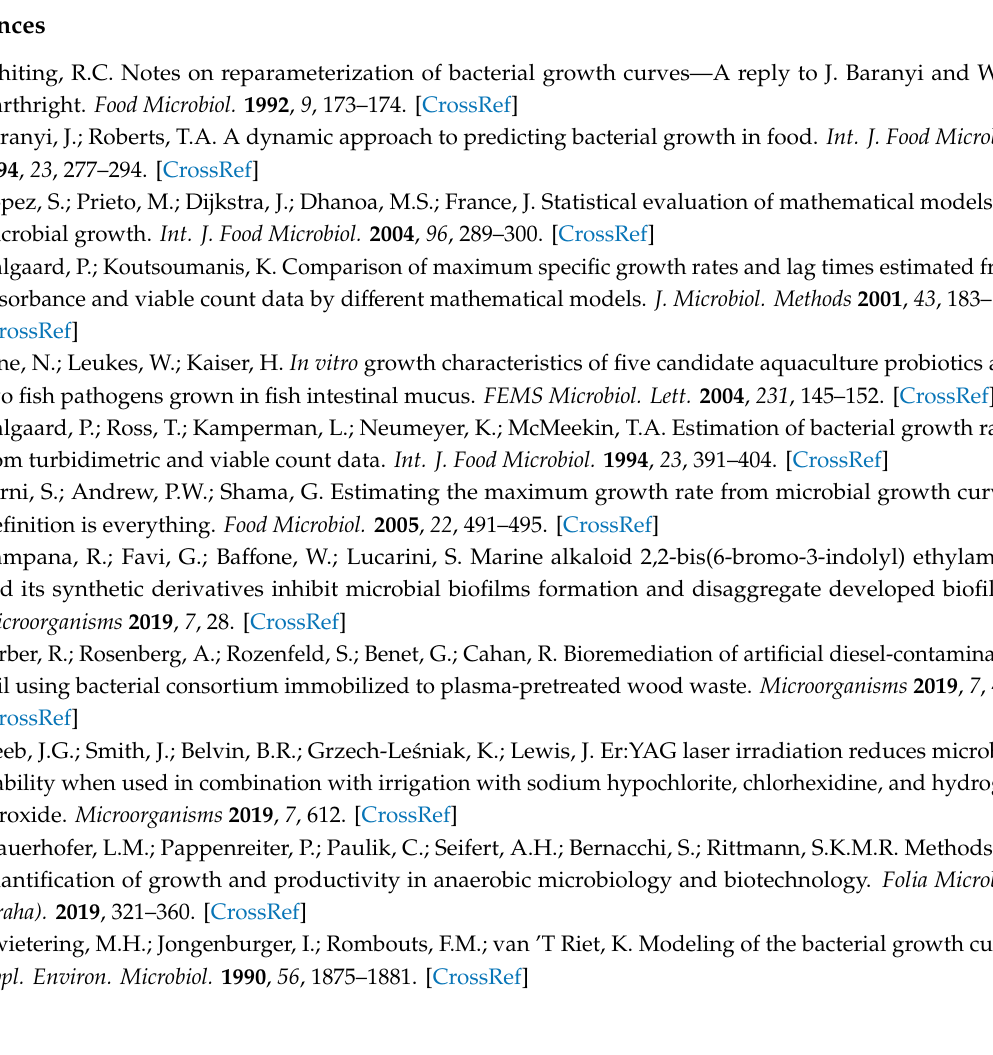
modified Cytophaga, (4) Cy7, (5) FLPB, (6) TYESB, (7) CBCM and (8) MAOB; Figure S1 : Optical density growth data and model predictions for Flavobacterium psychrophilum . Growth predictions using (a) LOG, log × hyp, log × exp (b) MLOG and BAR grown on a Sheih liquid medium; Figure S2: Optical density growth data and model predictions for Flavobacterium psychrophilum . Growth predictions using (a) LOG, log × hyp, log × exp (b) MLOG and BAR grown on a modified Cytophaga liquid medium; Figure S3 : Optical density growth data and model predictions for Flavobacterium psychrophilum . Growth predictions using (a) LOG, log × hyp, log × exp (b) MLOG and BAR grown on a Cy7 liquid medium; Figure S4 : Optical density growth data and model predictions for Flavobacterium psychrophilum . Growth predictions using (a) LOG, log × hyp, log × exp (b) MLOG and BAR grown on a TYESB liquid medium; Figure S5 : Optical density growth data and model predictions for Flavobacterium psychrophilum . Growth predictions using (a) LOG, log × hyp, log × exp (b) MLOG and BAR grown on a CBCM liquid medium; Figure S6 : Optical density growth data and model predictions for Flavobacterium psychrophilum . Growth predictions using (a) LOG, log × hyp, log × exp (b) MLOG and BAR grown on a MAOB liquid